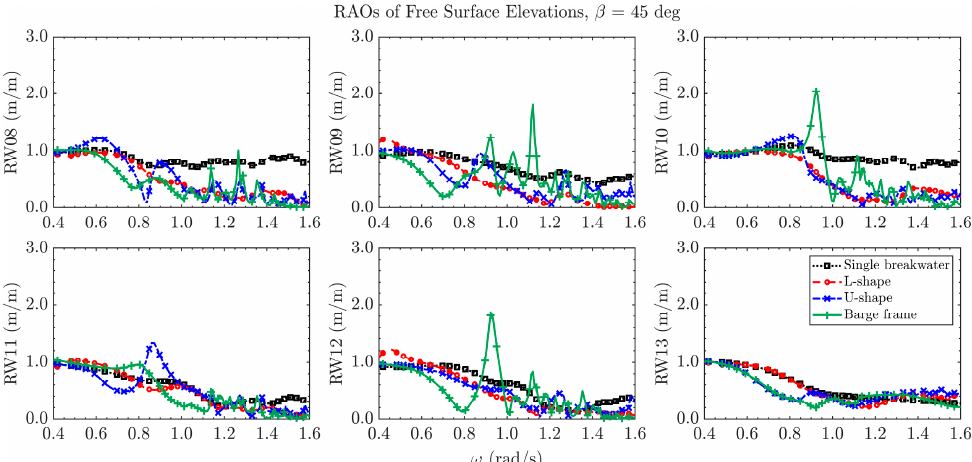
Figure 9. RAOs of free surface elevations at selected locations in the sheltered zone in 45 deg incident wave direction.